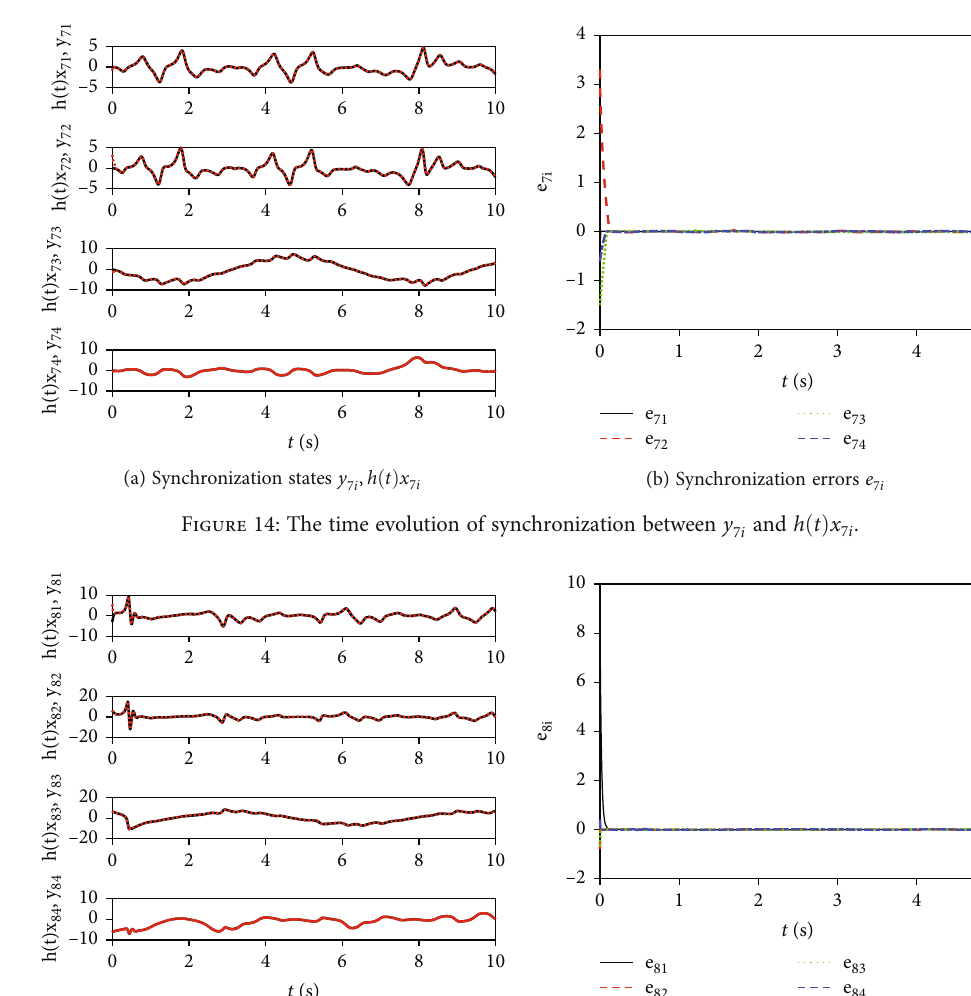
and h ð t Þ x . 6 i 6 i